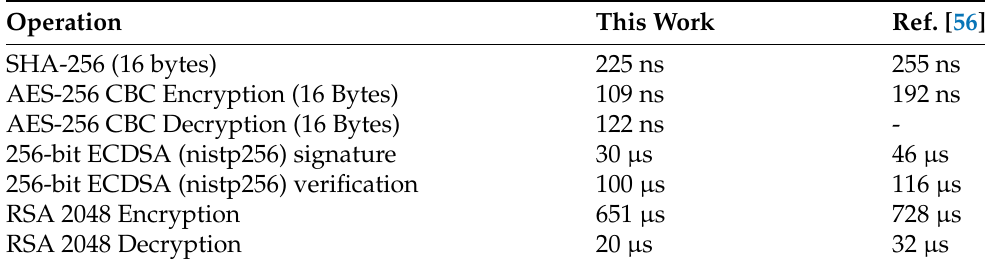
Table 4. Computational time for the cryptographic